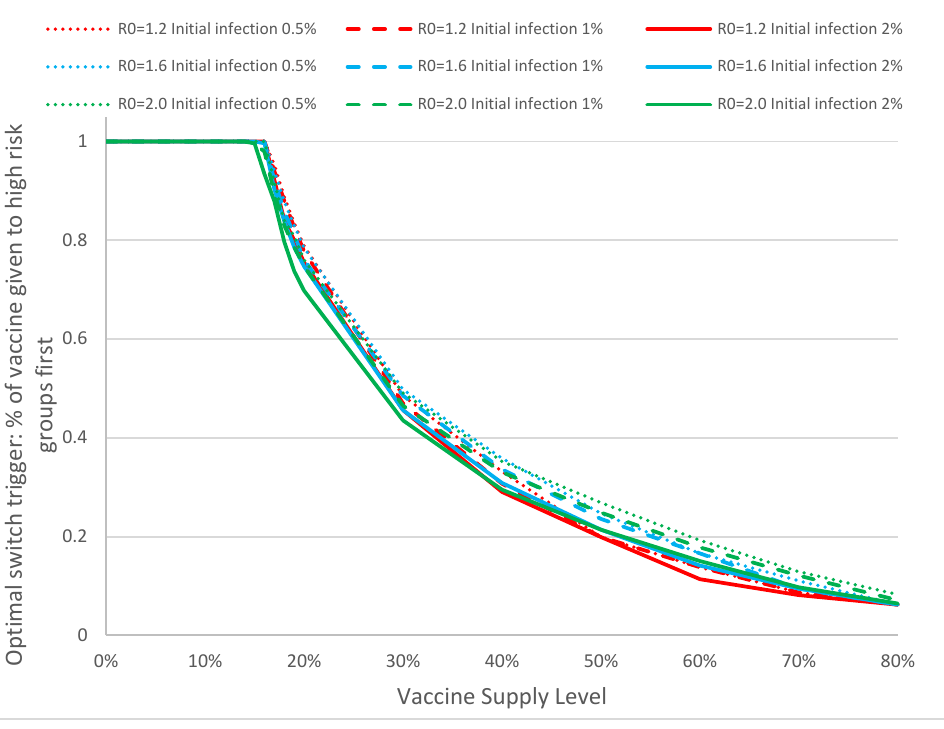
the high-risk groups) against the vaccine supply levels in the optimal mixed strategy for different